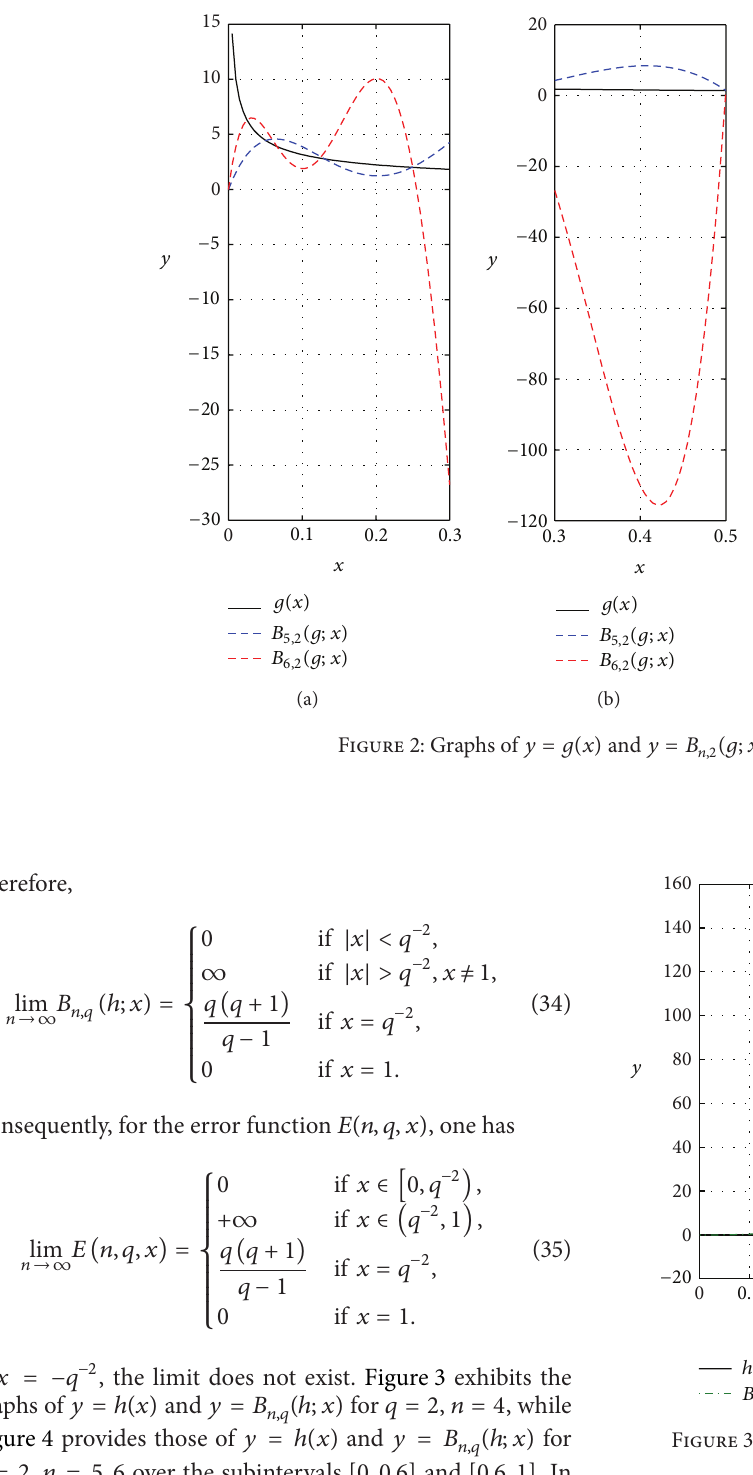
point 𝑥 = 𝑞 −2 , the values approach 6 from below, whereas for the remaining part of the table, the values of error function come close to zero as 𝑛 increases, which is in full agreement with the limit given by